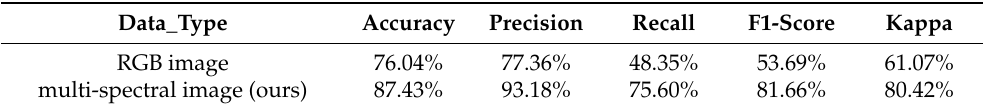
Figure 3. The standard confusion matrix of the MIDV algorithm. 0: normal flora, 1: AV, 2: BV, 3: VVC, 4: flora inhibition, 5: BV + AV, 6: BV middle, 7: BV middle + VVC + AV, 8: BV middle + VVC, 9: AV + TV, 10: abnormal flora combined clinically. Table 4. Comparison with RGB Image (multiple-label